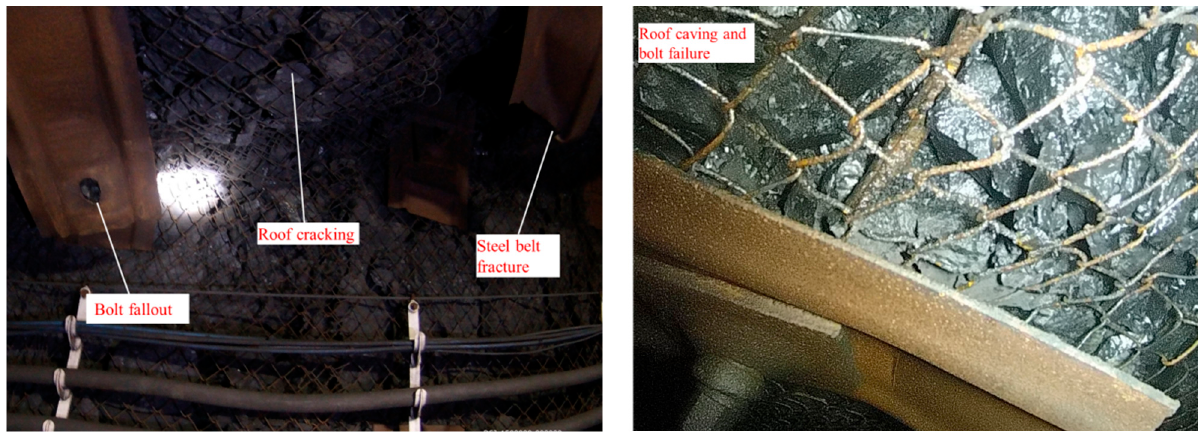
Figure 2. Deformation and failure conditions of the roadways.